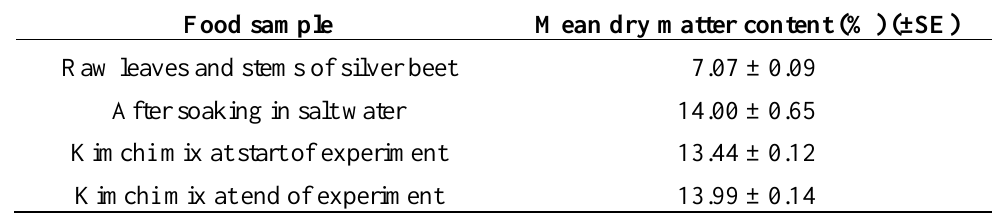
Table 1. Dry matter content of the raw and processed silver beet leaves and stems, and the kimchi mixes (%).